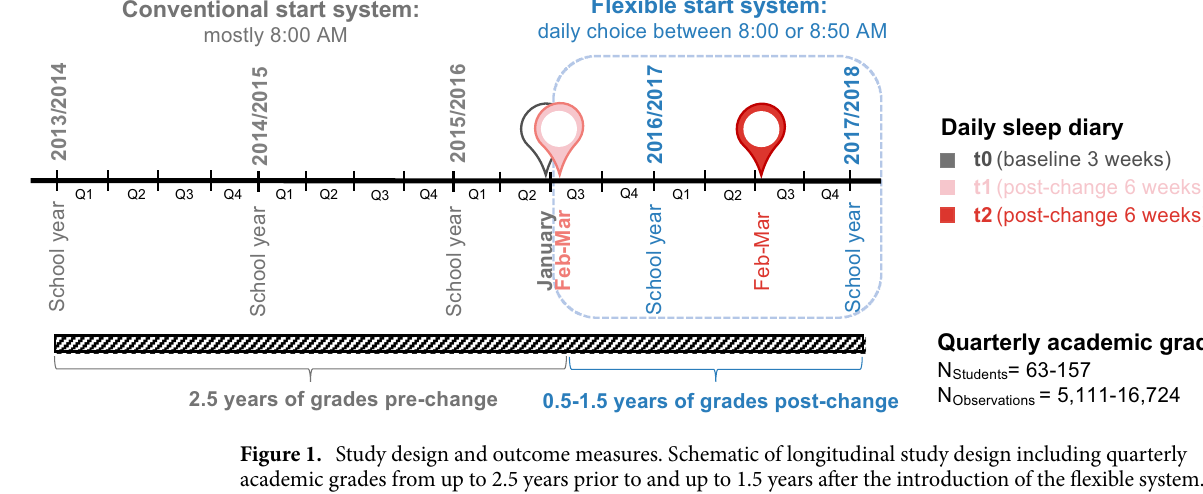
Figure 1. Study design and outcome measures. Schematic of longitudinal study design including quarterly academic grades from up to 2.5 years prior to and up to 1.5 years after the introduction of the flexible system. The same students had also provided daily sleep diary data in two waves (one baseline assessment in the conventional system and 2 time points in the flexible system as described previously 31